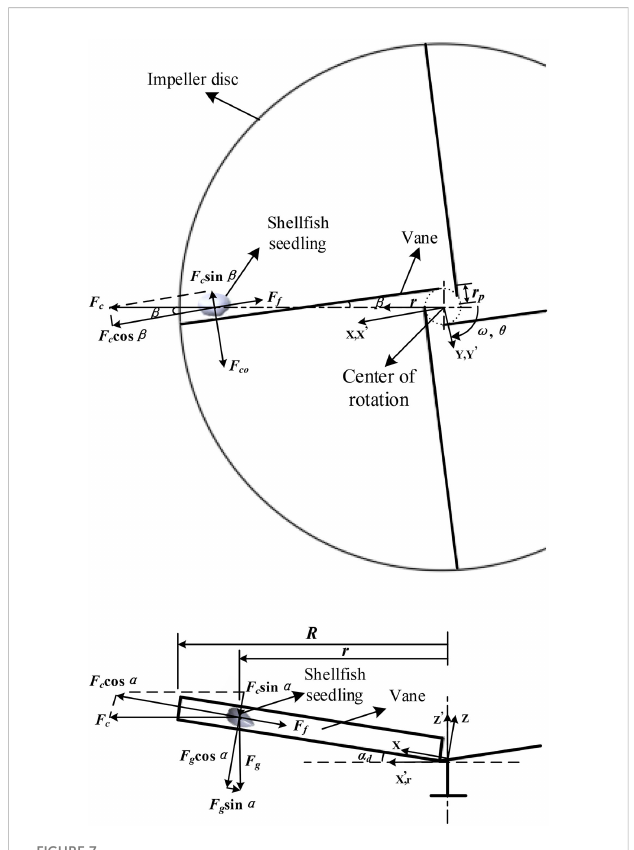
FIGURE 7 Analysis of the force of shell fi sh on the impeller